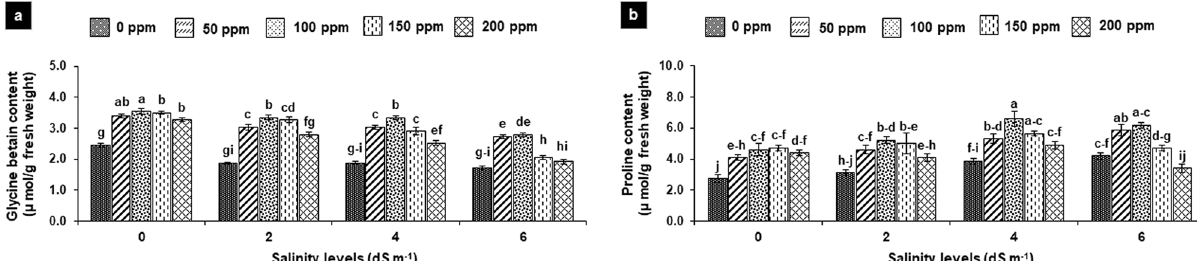
Figure 4. (a,b) Effects of foliar application of salicylic acid on the glycine betaine (b) and proline content (b) in Gladiolus grandiflorus irrigated with saline water. Vertical bars show standard errors of means of replicates. Different letters indicate significant differences (P < 0.05) according to LSD test; the same letter indicates no significant differences between the treatments.